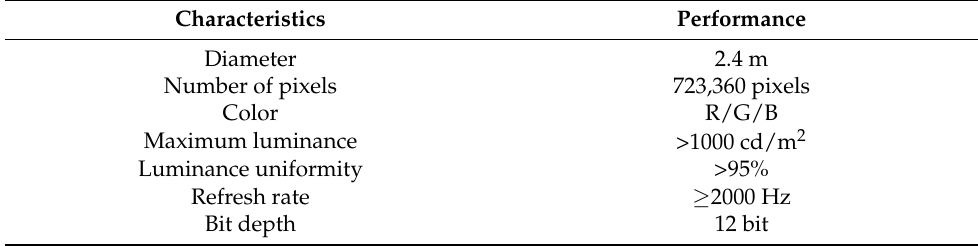
Figure 1. Schematic diagram of the apparatus during the experiment (unit: mm). Table 1. Technical characteristics of the hemisphere LED Screen.